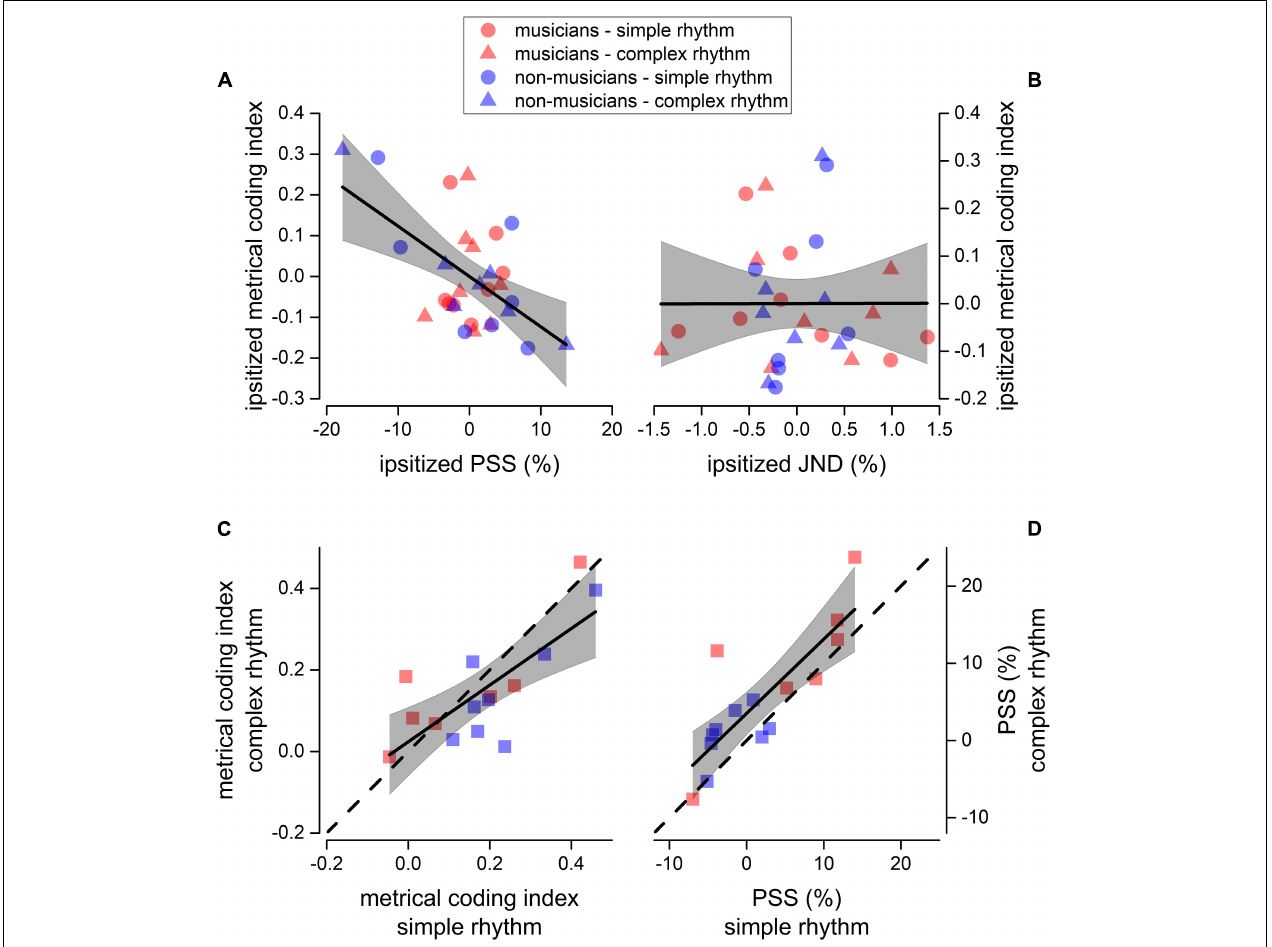
FIGURE 5 | . Sensorimotor correlation. Linear regression between ipsitized metrical coding index and ipsitized PSS (A) , and between ipsitized metrical coding index and ipsitized JND (B) . We plotted a value for each participant (musicians in red, and non-musicians in blue) and rhythm complexity (simple as circles, complex as triangles). Thick lines show the best linear regression of data, gray areas show 95% confidence band. The linear regression revealed a significant negative correlation between metrical coding index and PSS ( p < 0.05, see section “Materials and Methods for details). (C,D) Correlation between metrical coding index for simple ( x -axis) and complex ( y -axis) rhythms (C) and between PSS for simple ( x -axis) and complex ( y -axis) rhythms (D) . Dashed lines report the equality line, thick lines show the best linear regression of data, gray areas show 95% confidence band. Red and blue squares indicate musicians and non-musicians, respectively.